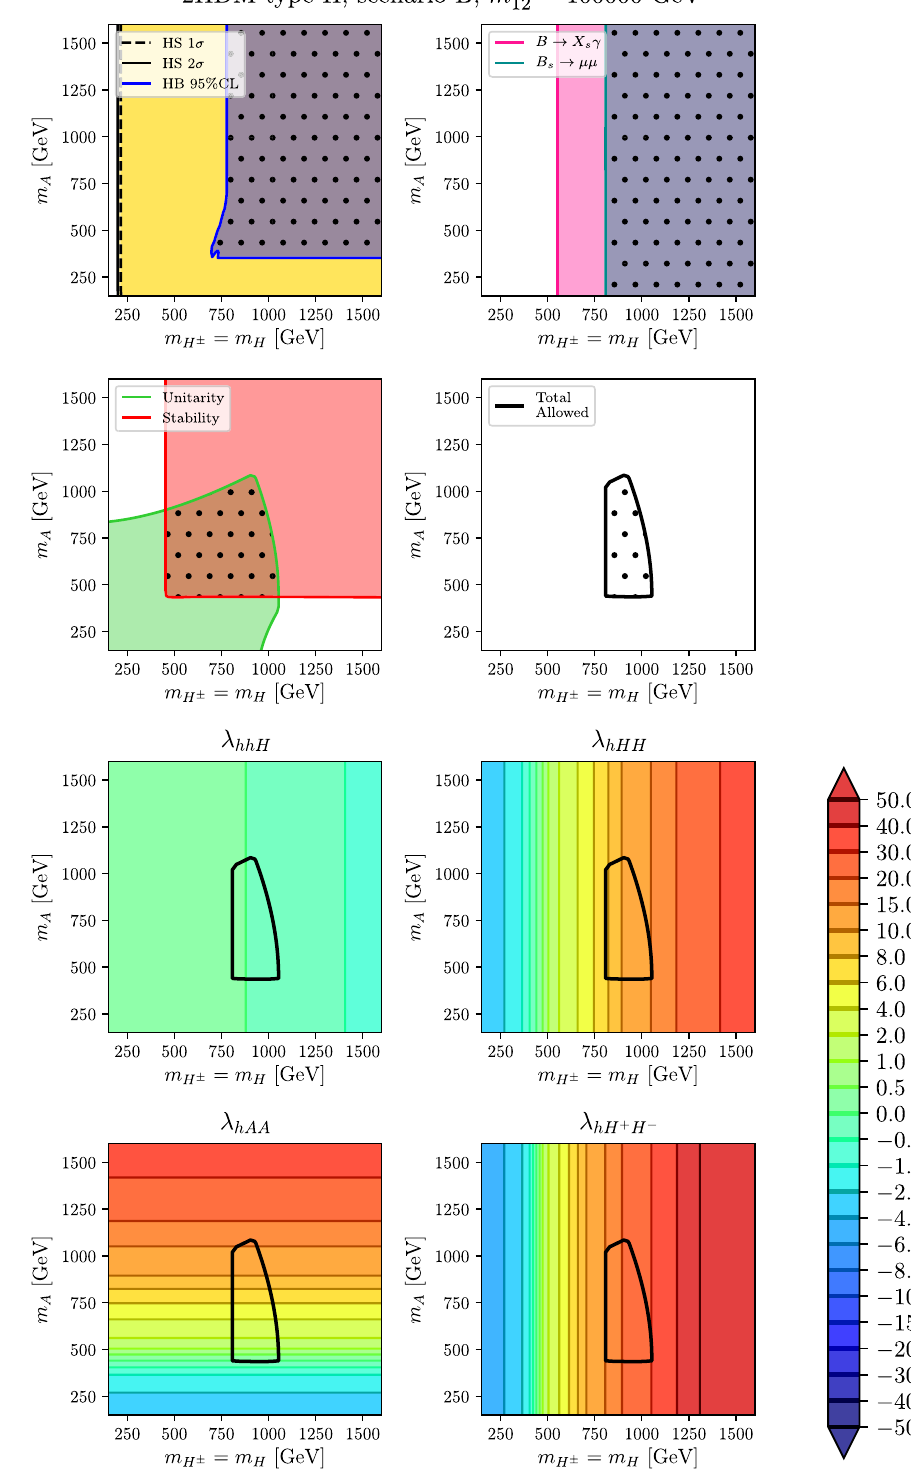
Fig. 20 Predictions for triple Higgs couplings in the 2HDM type II, scenario B, in the ( m H ± = m H , m A ) plane with c β − α = 0 . 05, = 100000 GeV 2 . Upper four plots: allowed tan β = 0 . 9 and m 2 12